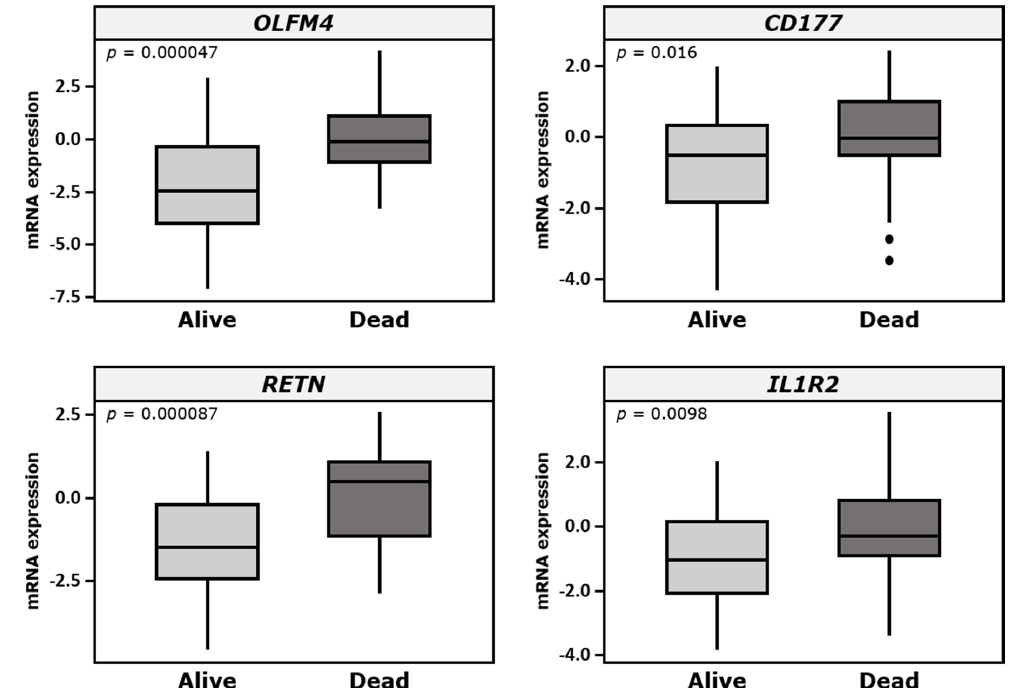
Figure 2. Relative mRNA levels of OLFM4 , CD177 , RETN , and IL1R2 in surviving patients and non-surviving patients as measured by qPCR. The primers and reference genes are given in the Methods section. Horizontal lines within the boxes represent the median, and the boundaries of the boxes indicate the 25th and 75th percentiles, while the whiskers indicate the highest and lowest values. The Y-axis represents the RNA expression levels in arbitrary units and logarithmic scale. qPCR, quantitative real-time polymerase chain reaction.